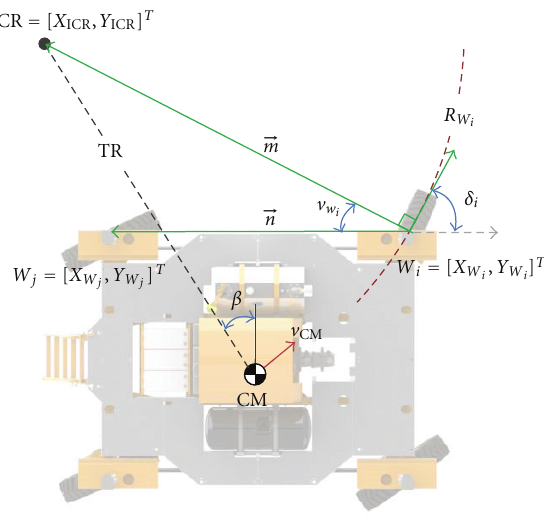
Figure 6: Variables in the Agribot kinematic